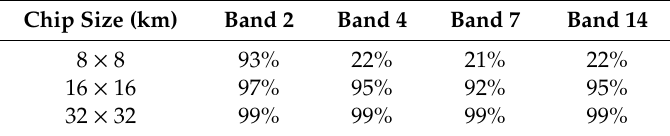
Table 4. AMV Quality (i.e., consistency) for the hurricane Michael